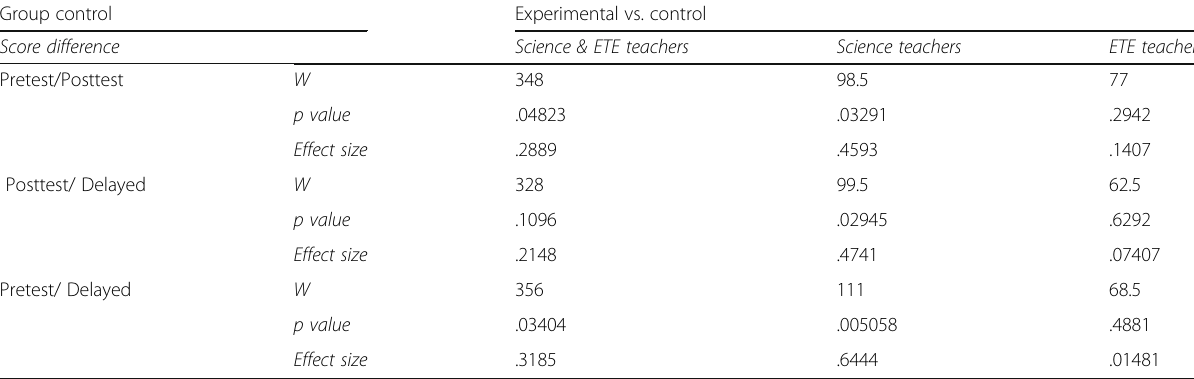
Table 8 Summary of Wilcoxon rank-sum test for significant differences between-groups (W, p value, and effect size) Group control Experimental vs.